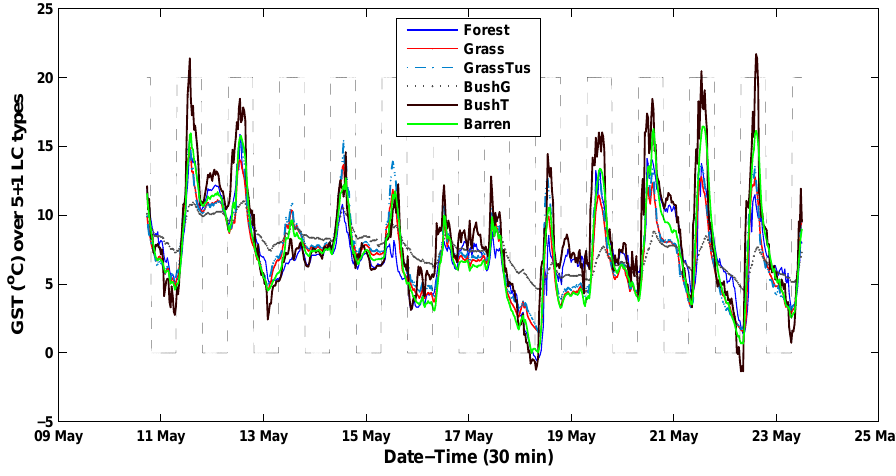
Figure 3. Comparison of GST time-series measured over 5 LC types plus the iButton on top of the bush (30-min data, May 2011). The broken grey-line is overlaid on the plot to distinguish day and night measurements; it is assigned 0 for night (7 pm–7 am) and 20 ◦ C for day (7 am–7